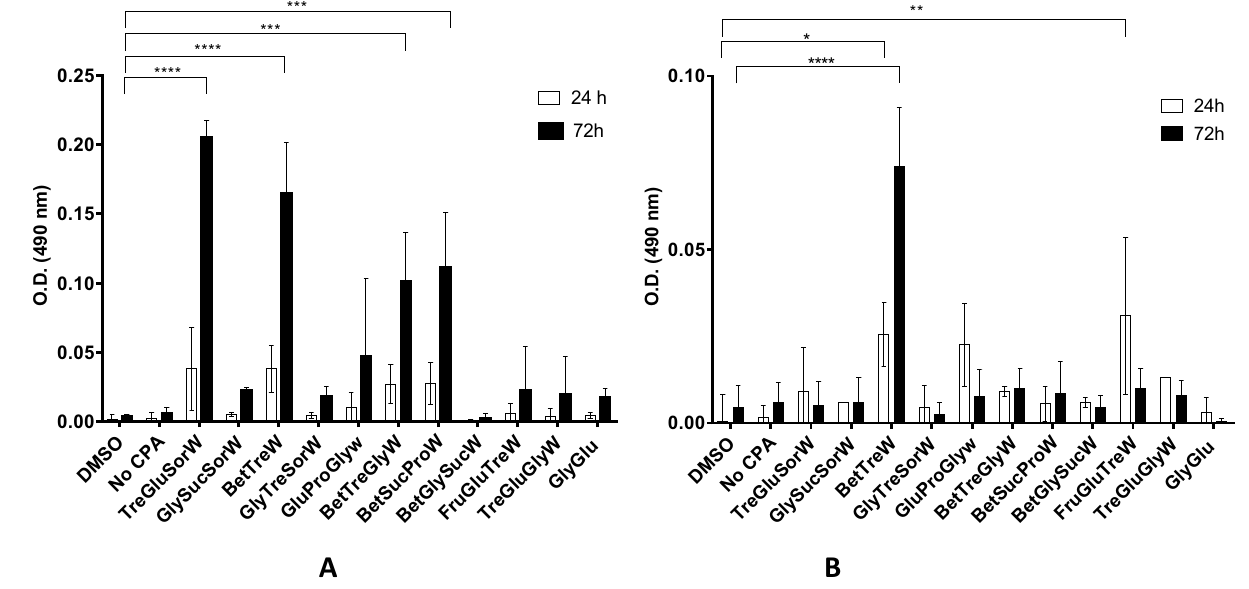
Figure 1. Initial screening of the post-thawing viability after vitrification in liquid nitrogen with either DMSO, no CPA or NADES. ( A ) in L929 cells. Data represent means ± SD (n = 2). Statistically significant differences are represented in asterisks: *** p < 0.001 and **** p = 0.0001, two-way ANOVA. The absence of asterisks means that there are no significant differences when compared with values of DMSO at the corresponding time points. ( B ) in HacaT cells. Statistically significant differences were determined by Turkey’s multiple comparisons test and are represented in asterisks: * p < 0.05, and ** p < 0.005; and **** p = 0.0001, two-way ANOVA. The absence of asterisks means that there are no significant differences when compared with values of DMSO at the corresponding time points.